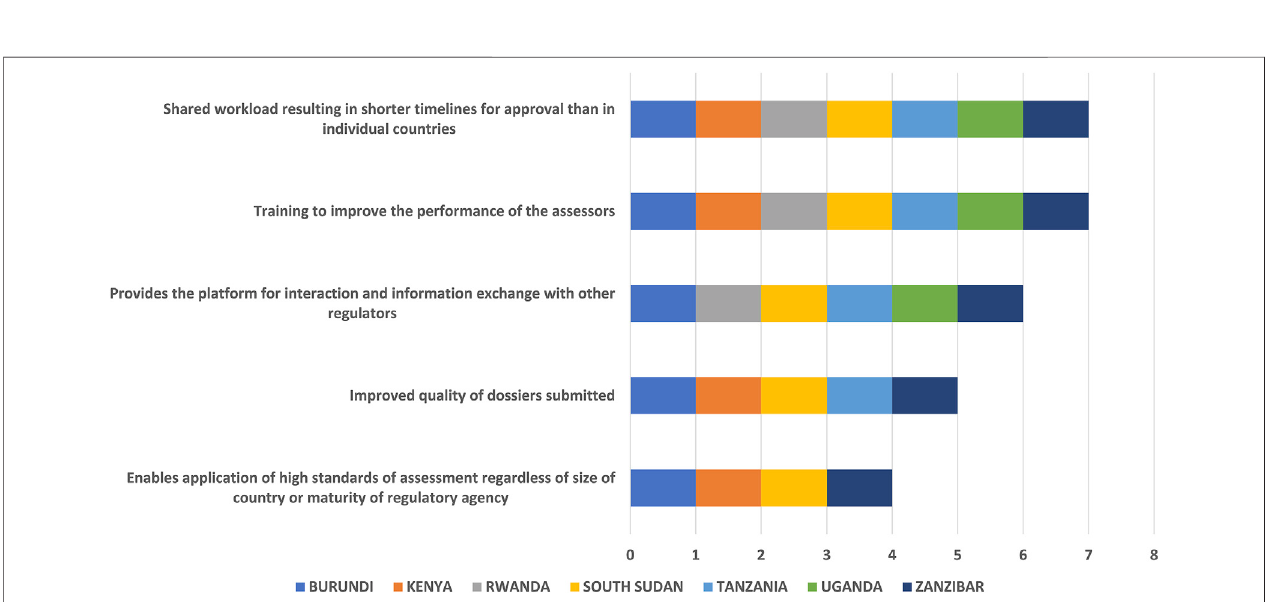
FIGURE 3 | Bene fi ts of the EAC-MRH initiative to regulators.